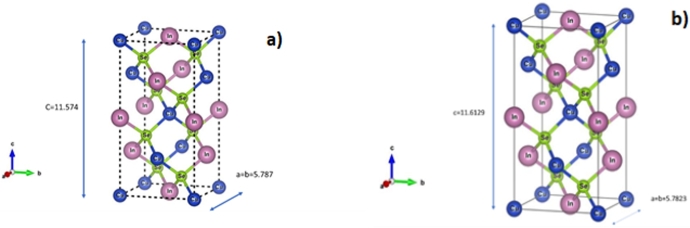
Schematic representation of CuInSe2 crystal structure conventional unit cell of height c, with a square base of width a for a) THM and b) VBM.